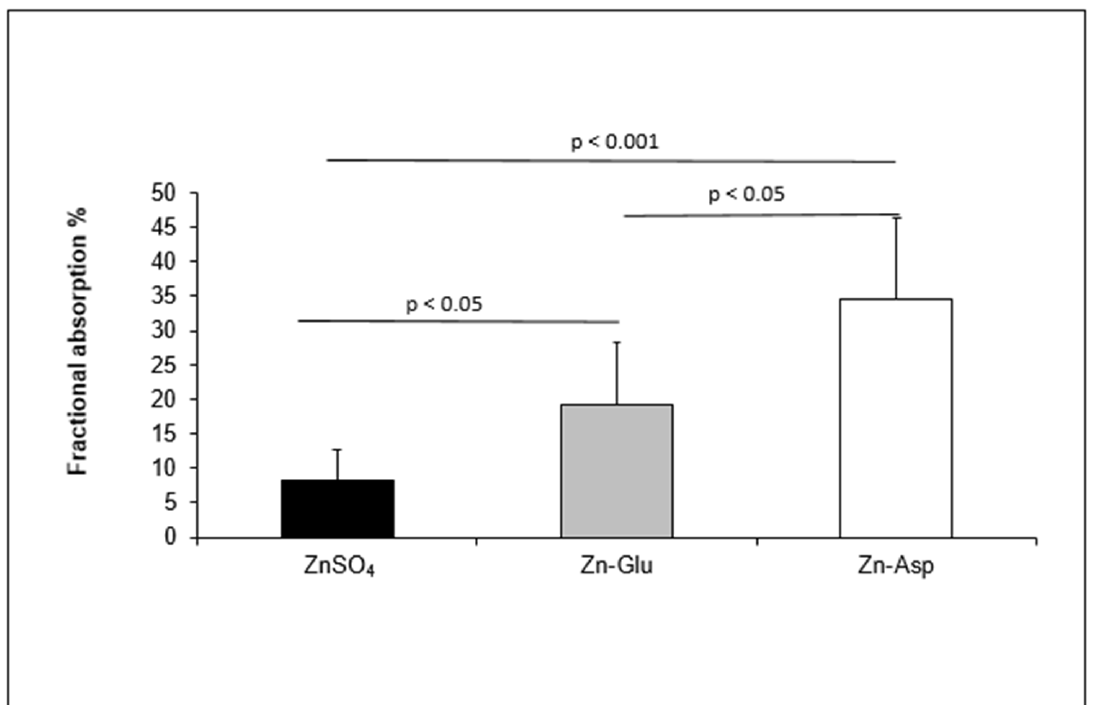
Figure 2. Comparison between the fractional Zn absorption obtained by oral administration of three di ff erent Zn complexes. The fi gure represents the comparison between the FZA measured after 48 h of oral administration of ZnSO 4 , Zn-Glu, and Zn-Asp in eight healthy human volunteers. FZA was determined via the ‘single-isotope’ methodology [44] using the following equation: FA = k (mg) × (%E of oral dose in urine/oral dose (mg)), where k (mg) is the value of 1.60 mg previously calculated [13], oral dose is 2 mg, and %E of oral dose in the urine is calculated as: %E 70 Zn = (( 70 Zn/ 66 Zn) enr − ( 70 Zn/ 66 Zn) base ) × %NA 66 Zn, where the %NA 66 Zn is the natural percentage of isotopic abundance of 66 Zn (27.90%). ZnSO 4 : zinc-sulphate; Zn-Glu: zinc-gluconate; Zn-Asp: Zn-Aspartate; %E: percentage enrichment.